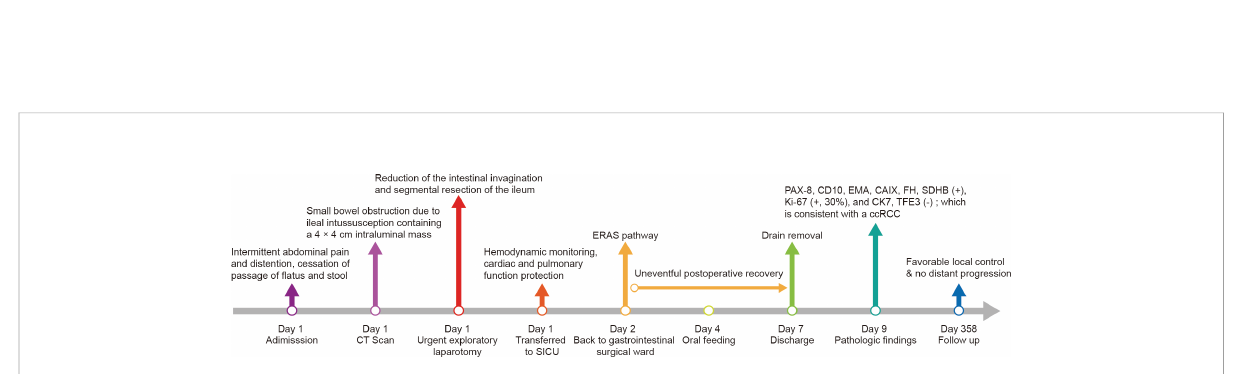
FIGURE 2 Timeline of the case presentation with relevant data. CT, computed tomography; SICU, surgical intensive care unit; ERAS, enhanced recovery after surgery; ccRCC, clear cell renal cell